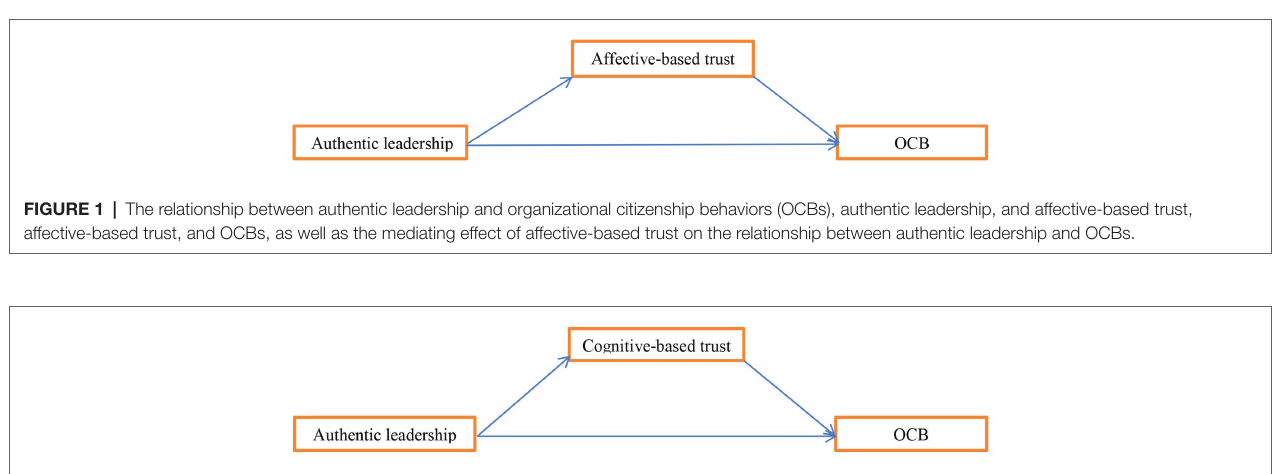
FIGURE 2 | The relationship between authentic leadership and cognitive-based trust, cognitive-based trust, and OCBs, as well as the mediating effect of cognitive- based trust on the relationship between authentic leadership and